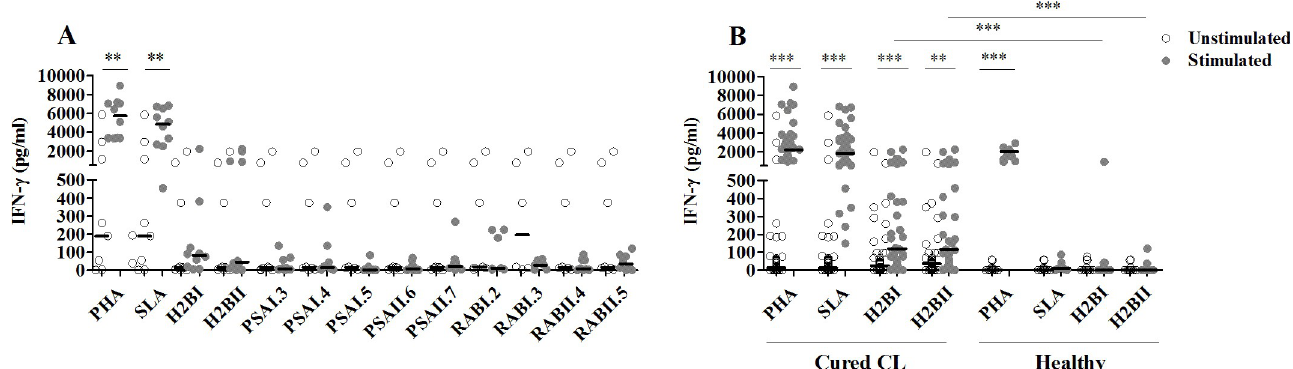
Fig 1. IFN- γ responses to multi-epitope peptides. IFN- γ was quantified by ELISA, in the culture supernatants of PBMC from cured CL subjects (N = 10) stimulated with multi-epitope peptides (1 μ M), for 10 days ( A ). PHA and SLA (10 μ g/ml) were used as positive controls. Unstimulated cultures (medium) were used as negative controls. H2BI and H2BII peptides were further evaluated in a larger number of cured CL (N = 40) as well as in healthy individuals (N = 12) ( B ). Horizontal bars represent median values. Statistical significance was assigned to a value of p < 0,05 ( �� p < 0.01, ��� p < 0.001).